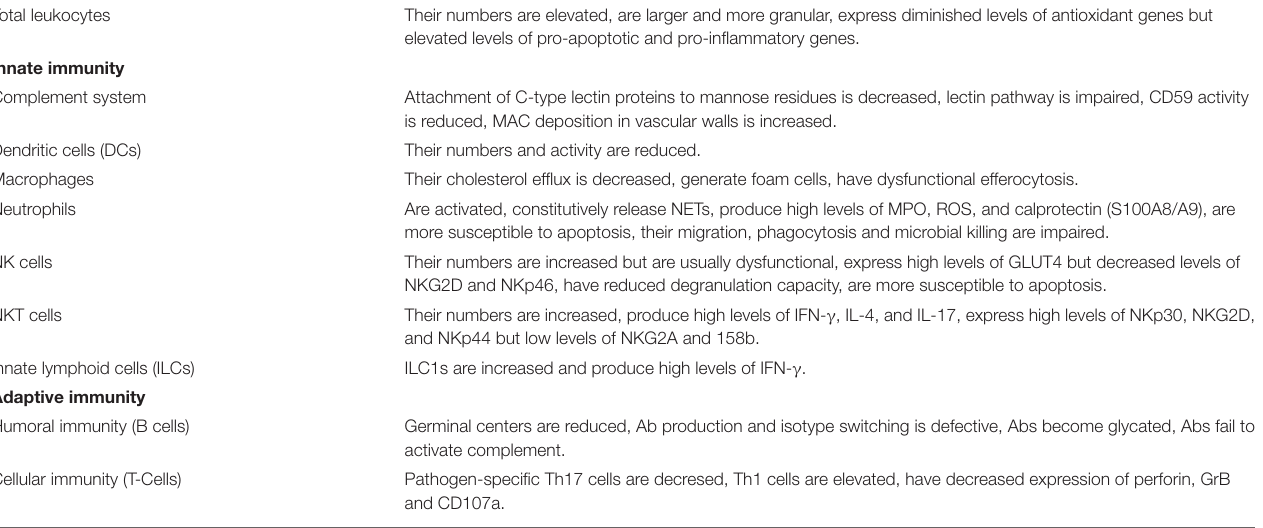
TABLE 2 | Effects of T2DM on the immune system. Total